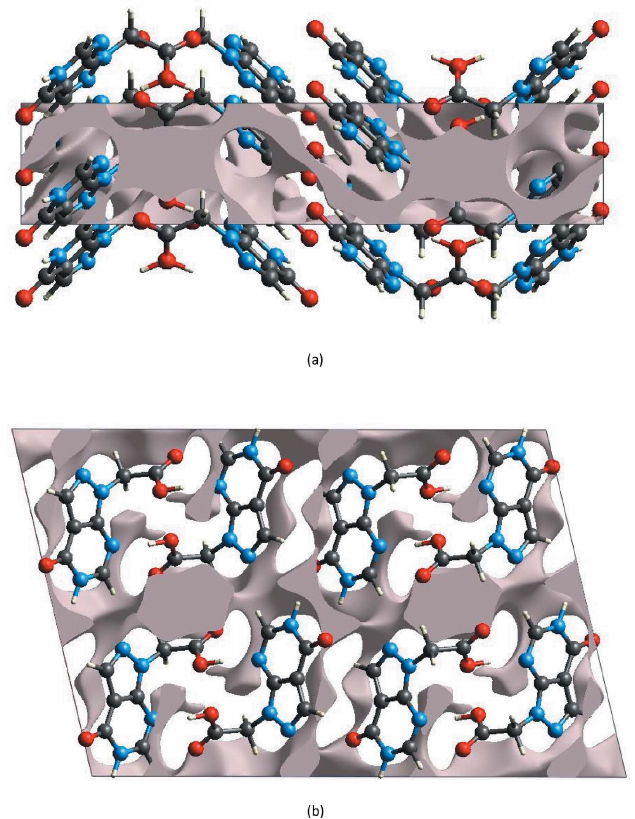
Figure 8 Graphical views of voids in the crystal packing of (I) ( a ) along the a- axis direction and ( b ) along the b- axis